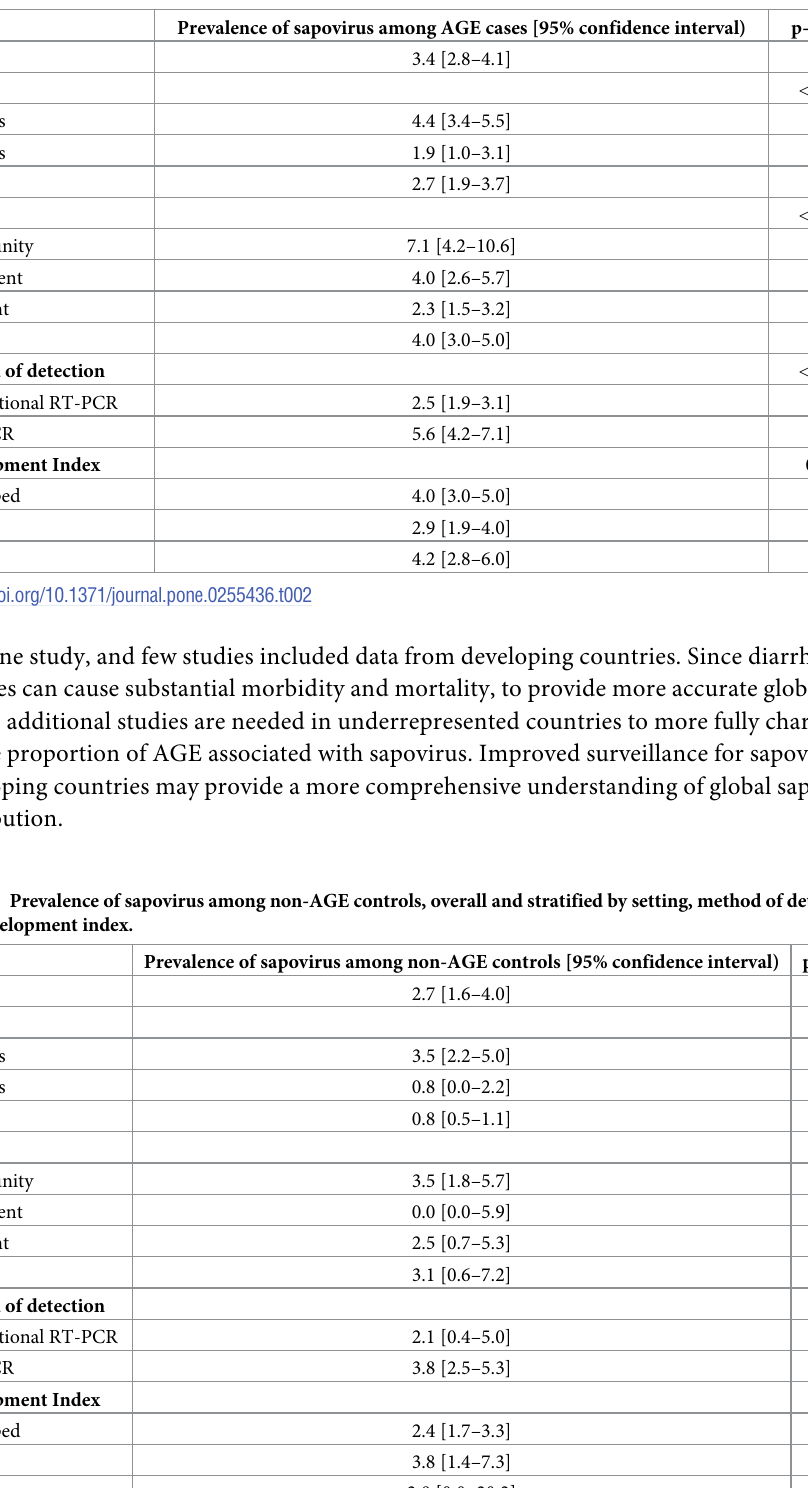
Table 2. Prevalence of sapovirus among AGE cases, overall and stratified by setting, method of detection, and development index.